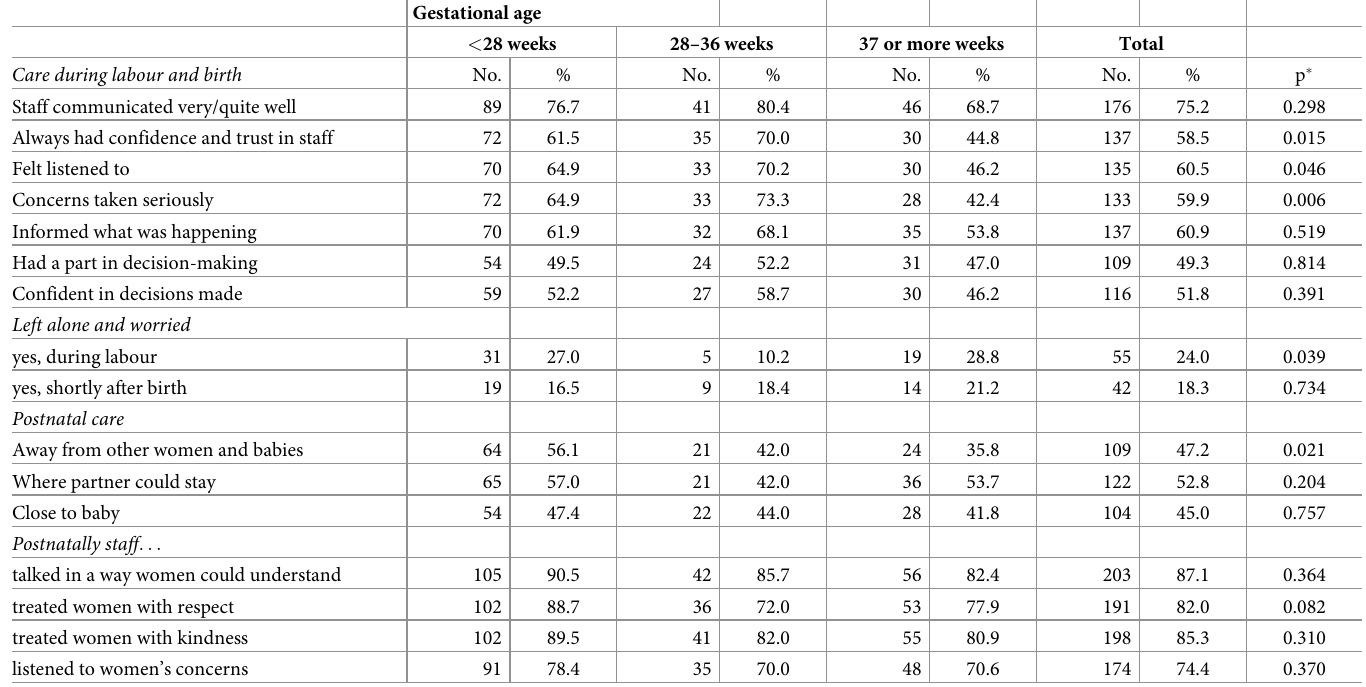
Table 3. Women’s perceptions of their care during labour and birth and in the immediate postnatal